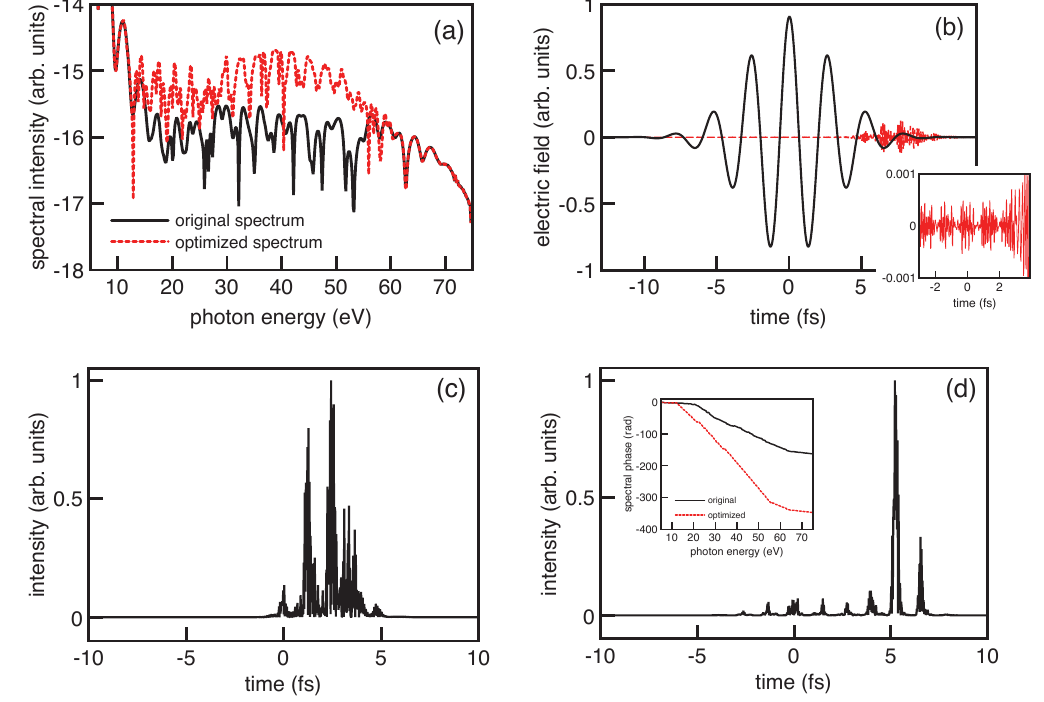
with respect to the original spectrum (black line), although the optimal XUV pulse corresponds to an 1 attenuation parameter as high as (cid:11) = 10 7 . As commented above, the fitness function considered for the spectral amplitude control is the normalized (cid:31) 2 function obtained from a linear regression of the spectral amplitude versus photon energy in the second interaction region. The normalized (cid:31) 2 parameter is minimized by the numerical algorithm in order to find the values of the attenuation (cid:11) and delay (cid:18) fitness parameters that produce a spectral amplitude shape the closest to a straight-line. The present results demonstrate that the fitness function (cid:31) 2 is indeed extremely efficient to achieve optimal isolated attosecond pulses by spectral amplitude shaping. As it can be observed from Figure 2c,d, the energy from the original HHG process is strongly compressed in time by the effect of the optimization process, which results in an almost single attosecond pulse, as shown in Figure 2d. Figure 2. (Color online) Optimization of the HHG spectral region 21–51 eV obtained by considering a single feedback loop. The scan in (cid:18) is from (cid:18) = − 720 ◦ to (cid:18) = 720 ◦ , and (cid:11) is scanned from (cid:11) = 10 6 to (cid:11) = 10 7 . The value of the normalized (cid:31) 2 function is 0.9998 for the original spectrum and 0.8929 for the optimized one. In ( a ) the spectral intensity of the original and optimized spectra are shown, as indicated. The IR driving pulse together with the optimal XUV pulse are shown in ( b ). The amplitude of the IR pulse is normalized, 1 and the one corresponding to the XUV pulse has been rescaled to allow its visualization. In 1 this case the optimal values of the fitness parameters are (cid:11) = 10 7 and (cid:18) = 718 ◦ . ( c ) and ( d ) show the temporal evolution of the intensities of the XUV pulses resulting from the second interaction region, before and after optimization, respectively, which are centered at a photon energy of 36 eV. The inset in ( d ) shows the spectral phase for the original and optimized spectra. Note that the labels in the vertical axis of ( a ) indicate a logarithmic